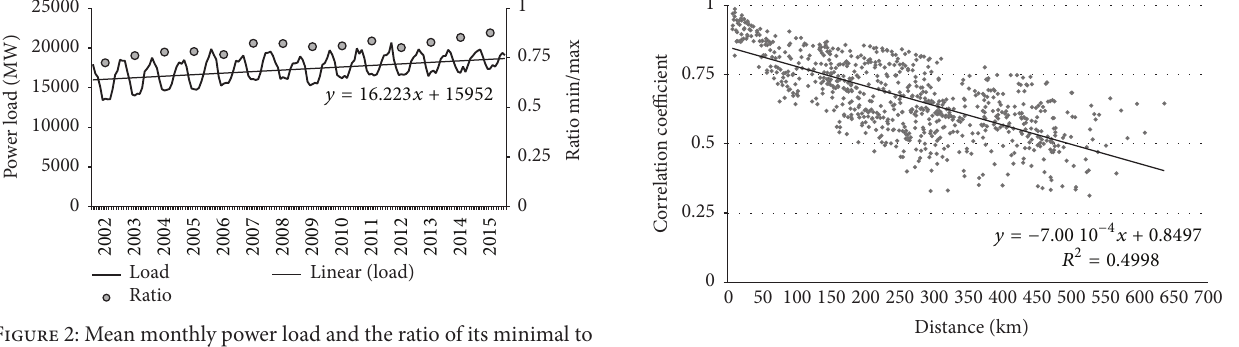
Figure 4: Values of correlation coefficients between irradiation time series (June 2005 with a 1-minute time step); the uncertainty of the slope parameter is − 3.68% whereas that of the intercept parameter is 0.9%.